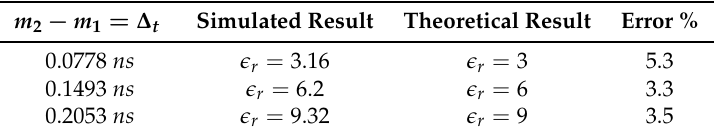
Table 2. Simulation measures (in time domain) obtained in three different materials. Simulated and theoretical results are compared. Time differences are obtained in waveguide transmission (shown in Figure